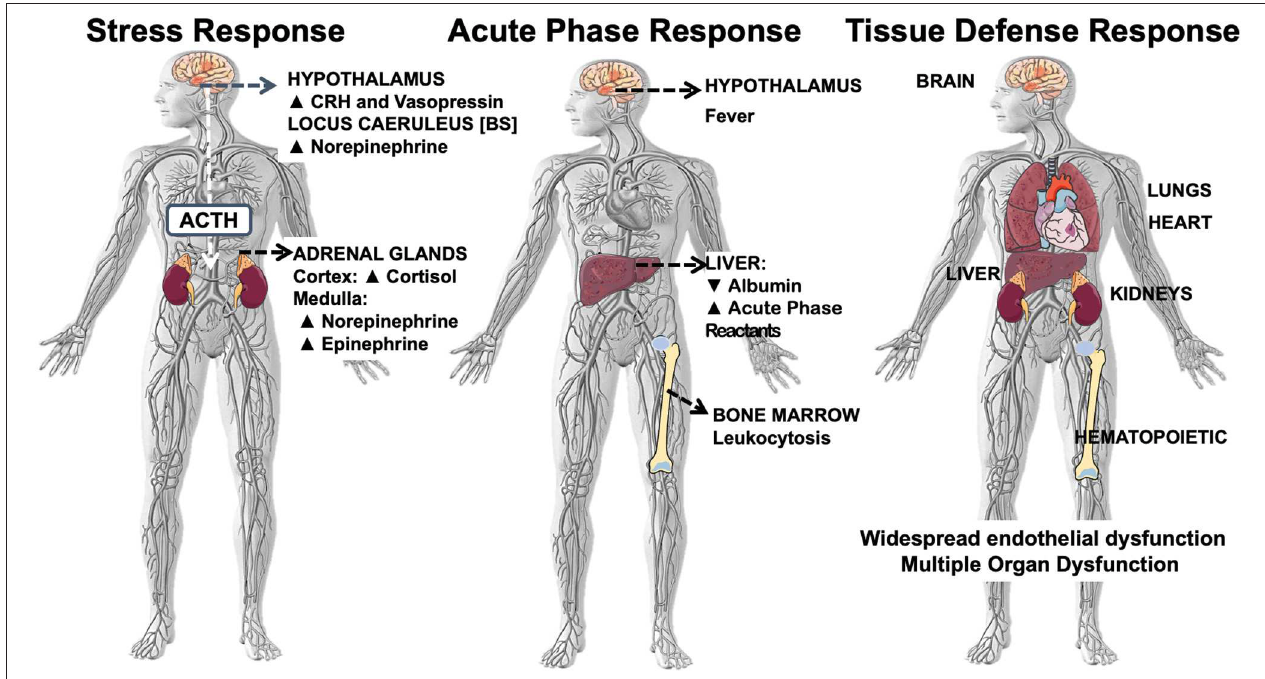
FIGURE 1 | Systemic inflammation-associated multi-system responses: stress, acute phase, tissue defense. Systemic inflammation-associated multi-system response that includes at least three major domains: (i) the stress system composed by the hypothalamic-pituitary-adrenal (HPA) axis and the locus caeruleus-norepinephrine/sympathetic nervous system; (ii) the acute-phase reaction (APR), and (iii) the tissue defense response of the target